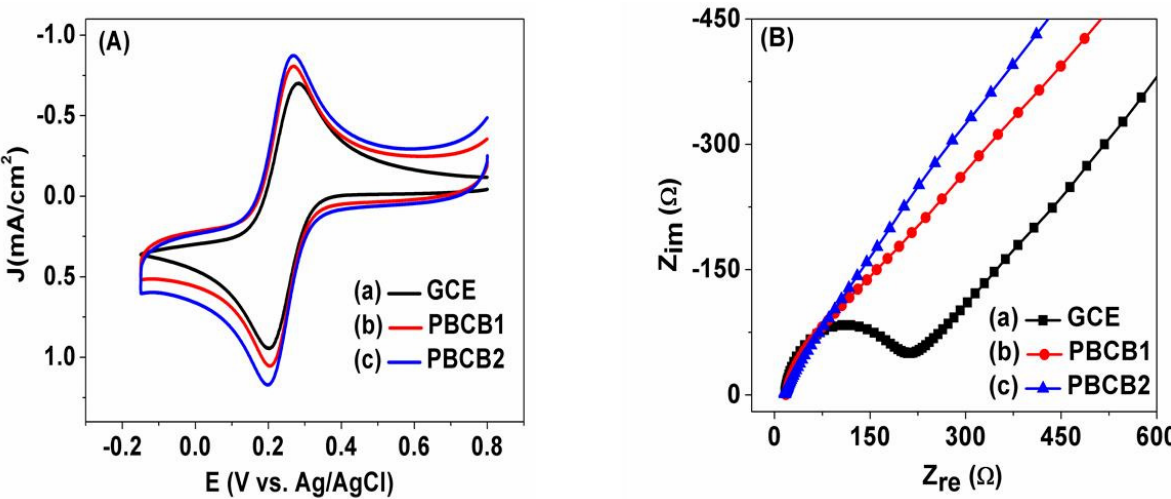
Figure 2. CVs ( A ) and EIS ( B ) spectra of 5.0 mM K 3 [Fe(CN) 6 ] in 1.0 M KCl at GCE (a), PBCB1(b), and PBCB2 (c).